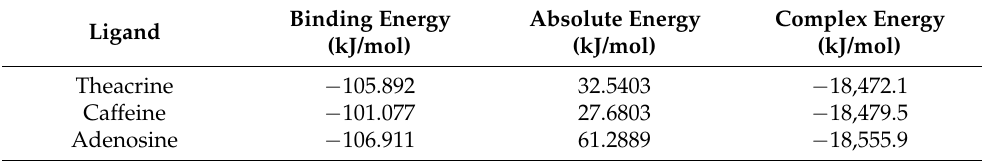
Figure 1. Molecular modeling of intermolecular interaction between the binding pocket of the adenosine 2A receptor (ADORA2A) and theacrine ( A ), caffeine ( B ) or adenosine ( C ). The red dashed lines are conventional hydrogen bonds. The yellow dashed lines are carbon hydrogen bonds. The green color represents Van der Waals force. The gray dashed lines show Pi–Pi stacking. The pink dashed lines indicate alkyl bonds. The amino acids of ADORA2A involved in the interaction with the three ligands are shown in colored balls. Table 1. Theoretic binding energy for the interaction between the binding pocket of the adenosine 2A receptor (ADORA2A) and theacrine, caffeine or adenosine.